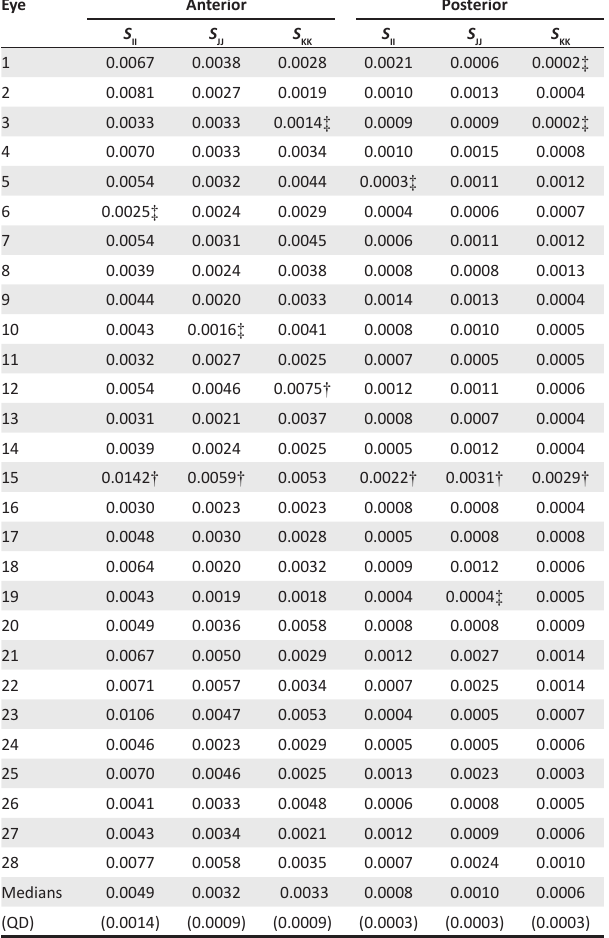
TABLE 5: Variances (D 2 ) extracted from the variance-covariance matrices for anterior and posterior CCP for 28 control eyes where S stigmatic and antistigmatic variances, respectively. Maxima and minima for each column are indicated in red and blue, respectively. Medians and QD are also included. Note that because of the small variances for controls, the values were rounded off to four places after decimal points.